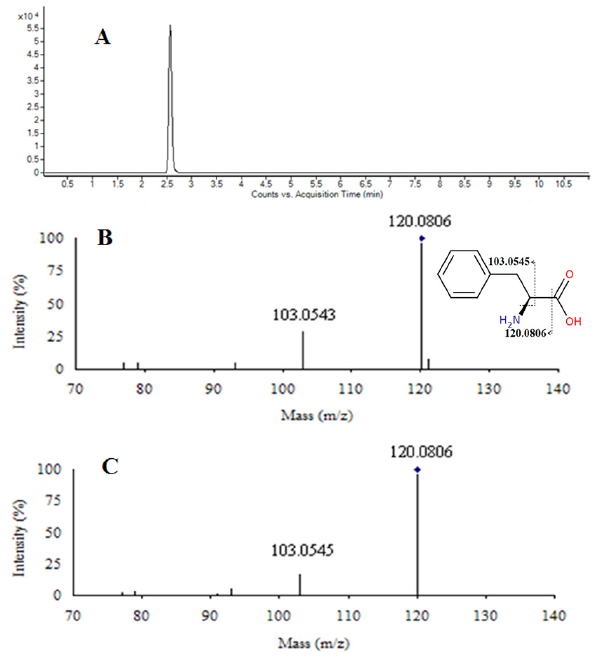
Figure 6. Identification of a selected marker ( m / z 166). ( A ) Extracted ion chromatogram (EIC) of m / z 166; ( B ) MS/MS spectrum of the ion; ( C ) MS/MS spectrum of a commercial standard L -phenylalanine. The collision energy was 20 V.